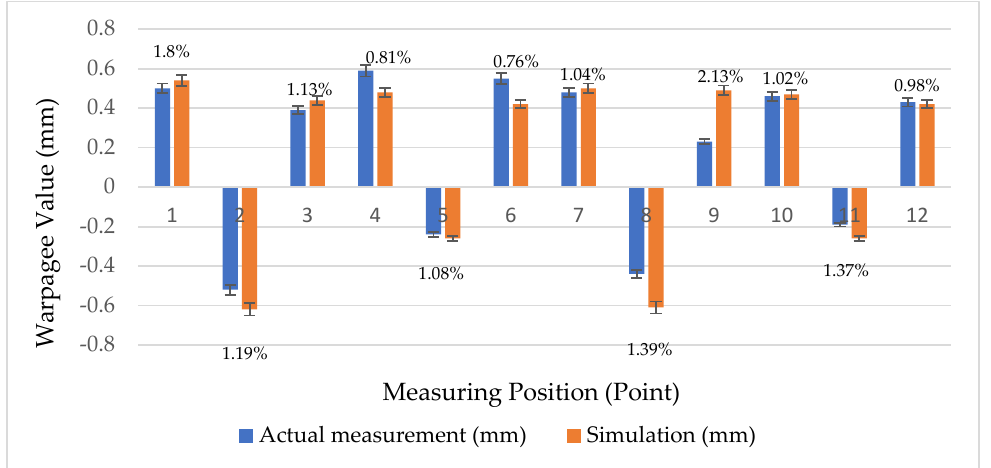
Figure 4. Comparison of Actual and Simulated Measurement Points.